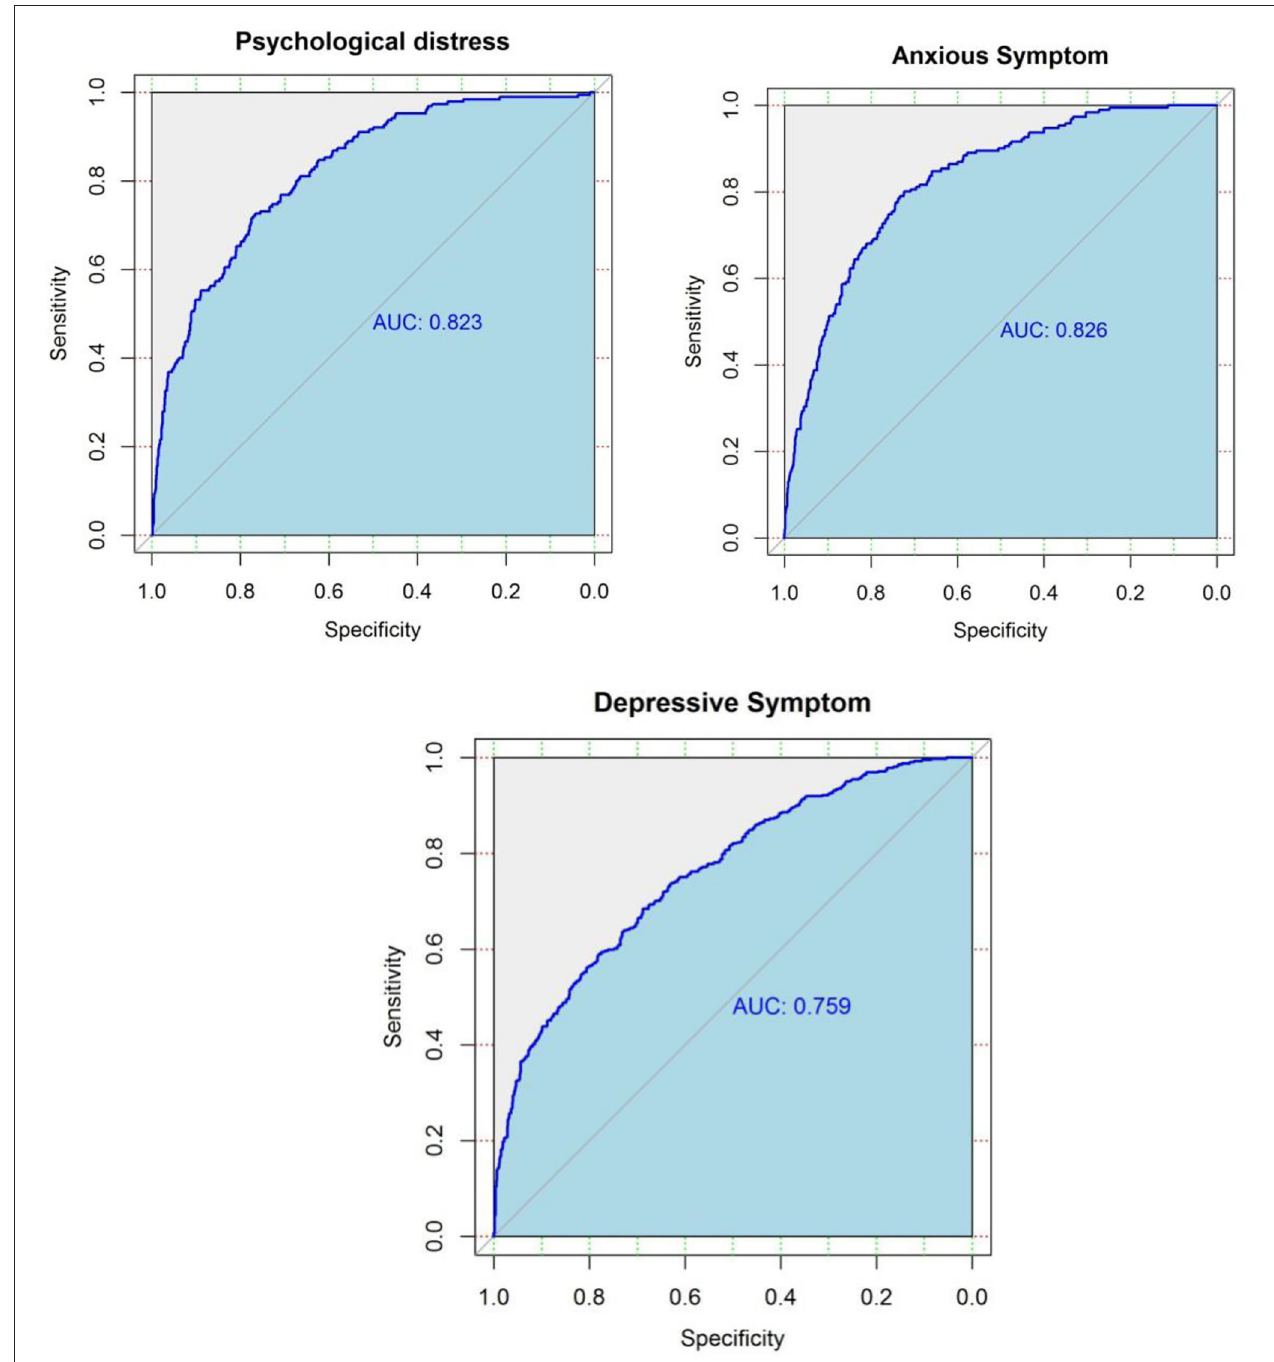
FIGURE 1 | Receiver operating characteristic (ROC) curves for predicted probability of the symptoms of common mental disorders among medical staff based on elastic net algorithm in the test dataset (25% of the whole sample).